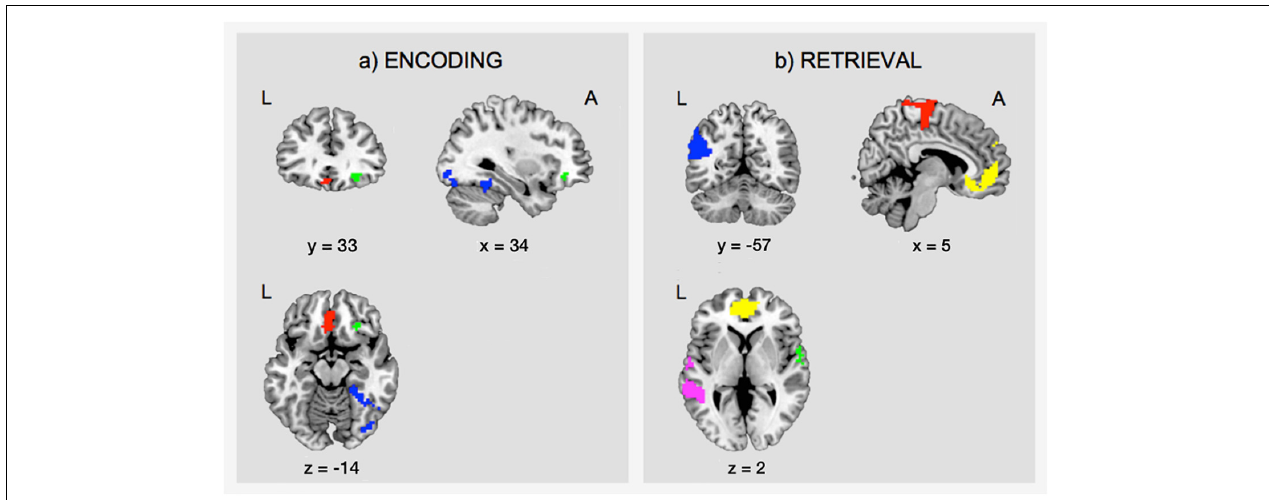
FIGURE 4 | Task-related fMRI data. The figure shows (a) the subsequent memory effect during encoding (green, orbitofrontal cortex; blue, right inferior occipital gyrus and fusiform gyrus; red, left ventromedial prefrontal cortex), and (b) the main effect of memory during retrieval (yellow, ventromedial prefrontal cortex; pink, middle temporal gyrus; green, superior temporal gyrus; blue, angular gyrus; red, precentral gyrus). The figure shows clusters whose peak survived a threshold of p-FWE < 0.05. For display purposes, clusters are depicted at a threshold of p < 0.001, uncorrected for multiple comparisons. L, left; A, anterior. p = 0.541, Bonferroni-corrected; right IOG/fusiform gyrus – left IFGtriangular: t (17) = − 0.817, p = 0.425, Bonferroni-corrected; right IOG/fusiform gyrus – left IFGorbital: t (17) = 0.381,